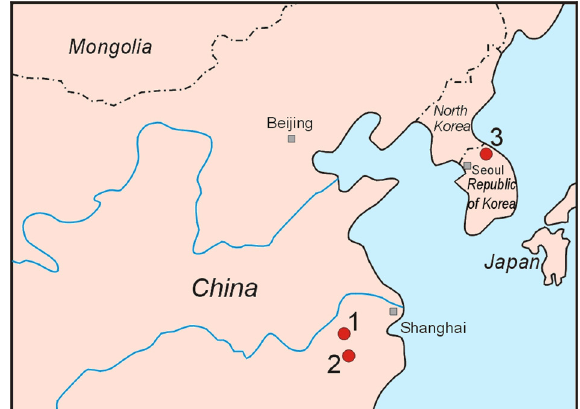
Fig. 1. Location of three granite areas mentioned in the paper in East